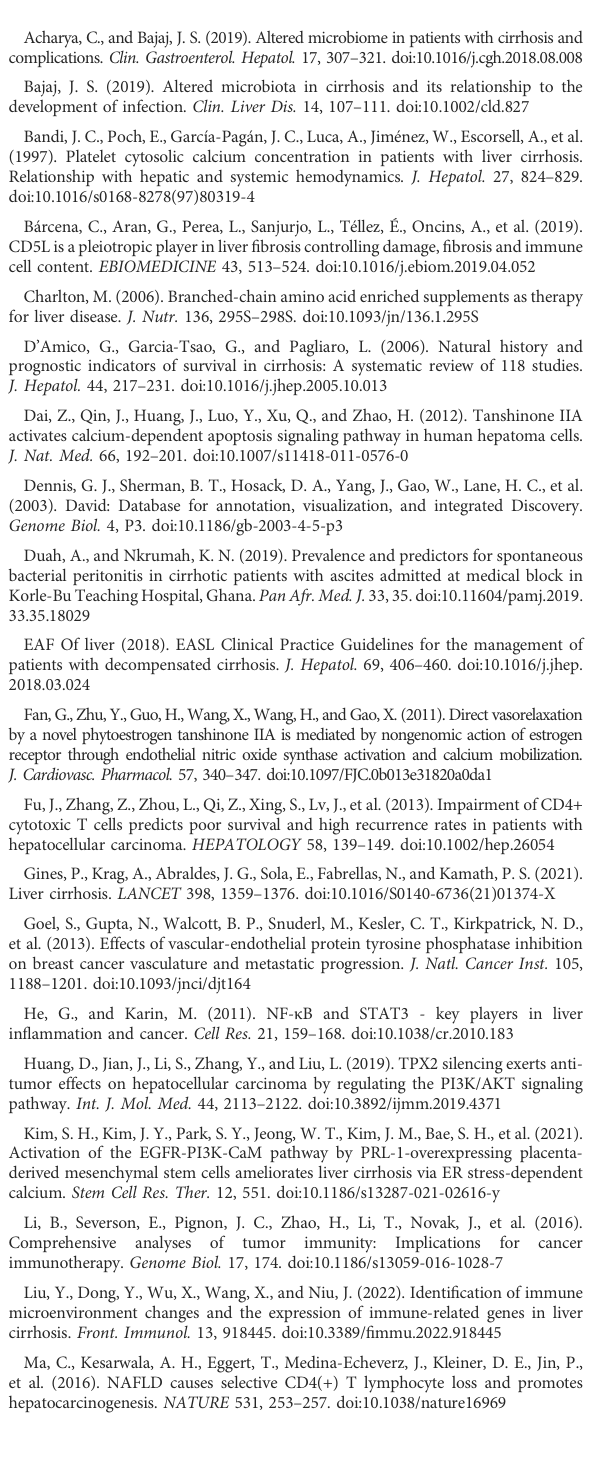
SUPPLEMENTARY FIGURE S5 Knockdown of AKR1C3 and TPX2 suppressed tomor magliance of HCC cells. (A) Left panel: wound healing assay of cells after transfecting with AKR1C3 siRNAs. Right panel: statistical anaylsis results of migration diatancepercentage, 5 measurements wascalculated for each group. (B) Left panel: wound healing assay of cells after transfecting with